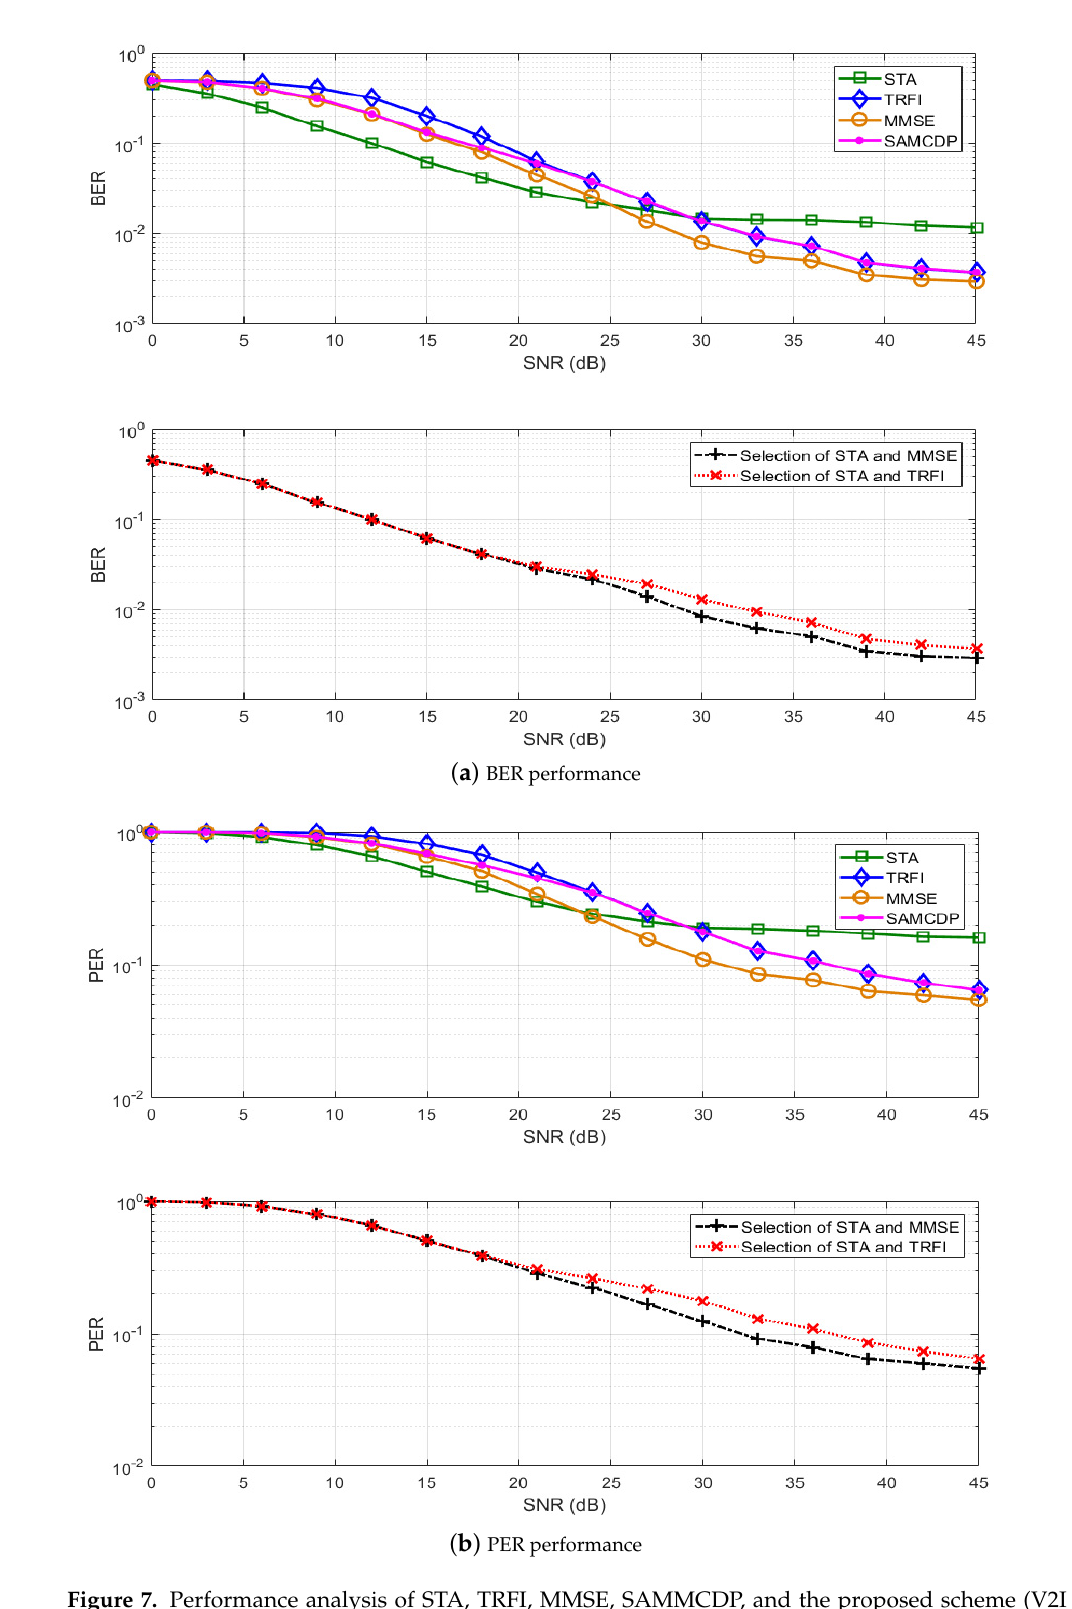
Figure 7. Performance analysis of STA, TRFI, MMSE, SAMMCDP, and the proposed scheme (V2I Urban Canyon, QPSK 1/2, 50